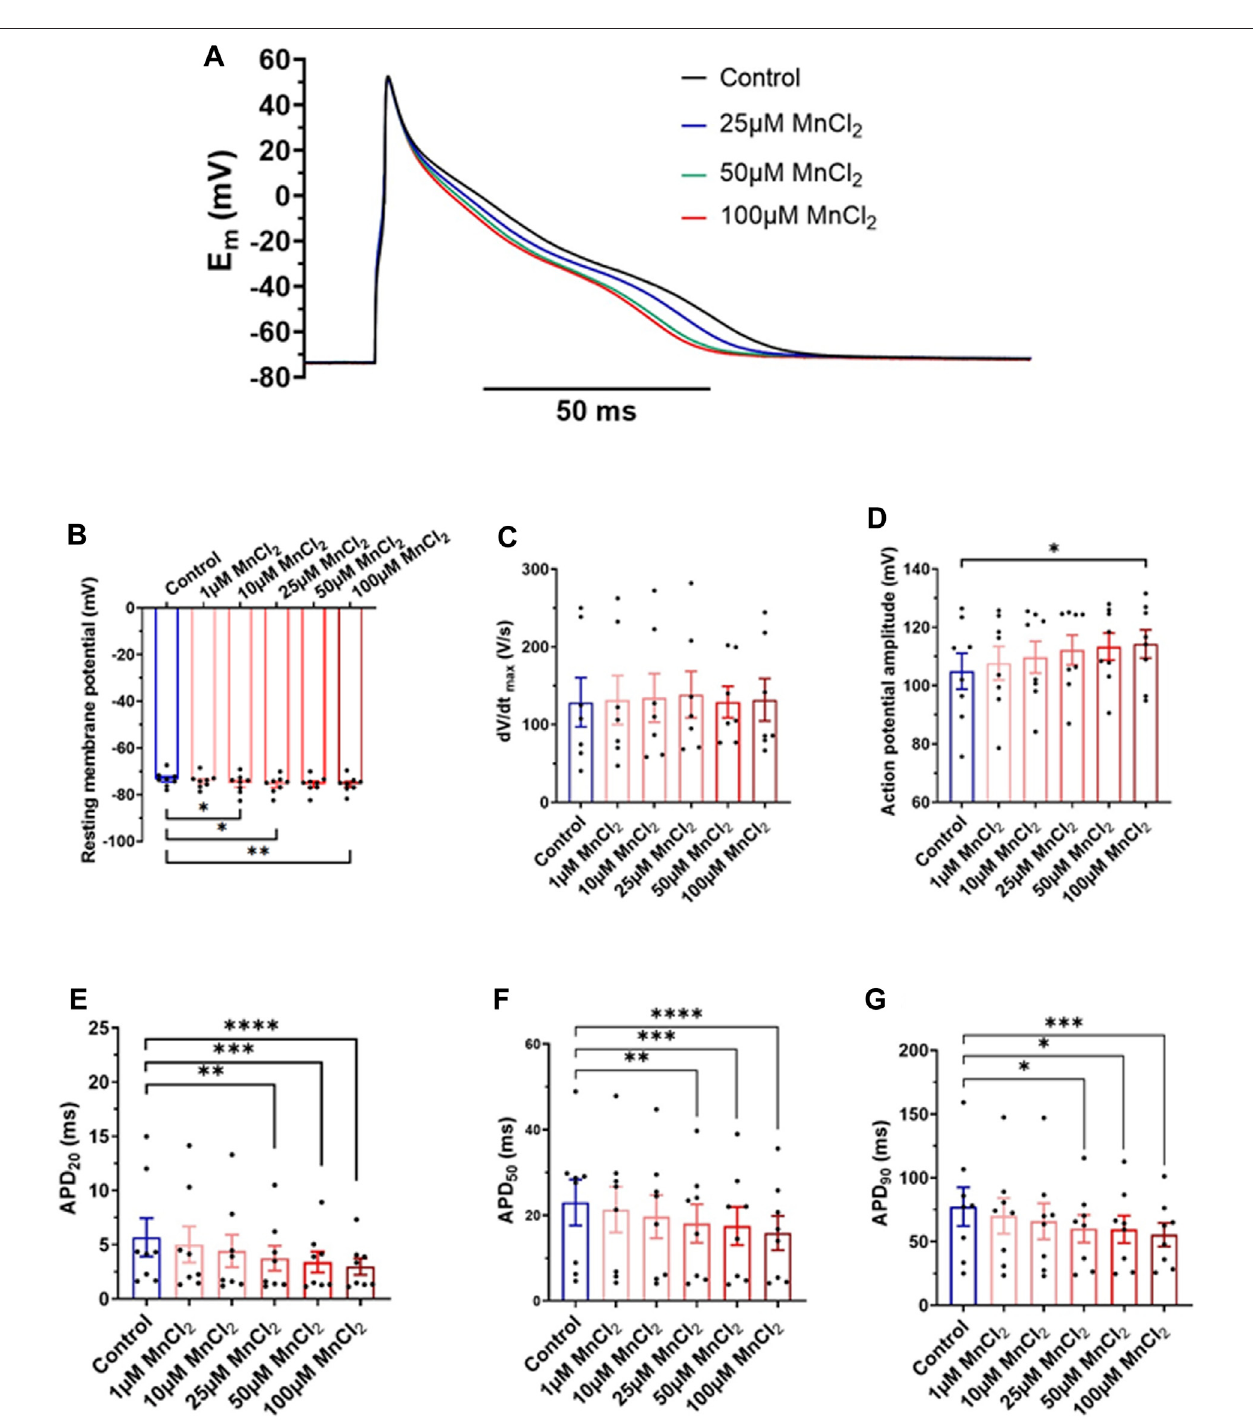
FIGURE 5 | Effects of MnCl 2 on action potentials of rat ventricular cardiomyocytes (A) Representative plots of action potentials in control condition and at 25, 50 and100 µMMnCl 2 (B) Restingmembranepotential (C) dV/dt max (D) amplitudeofpeak (E) APD 20 (F) APD 50 and (G) APD 90 dependingondifferentconditions( N =4; n = 8). * p < 0.05, ** p < 0.01, *** p < 0.001, **** p < 0.0001.